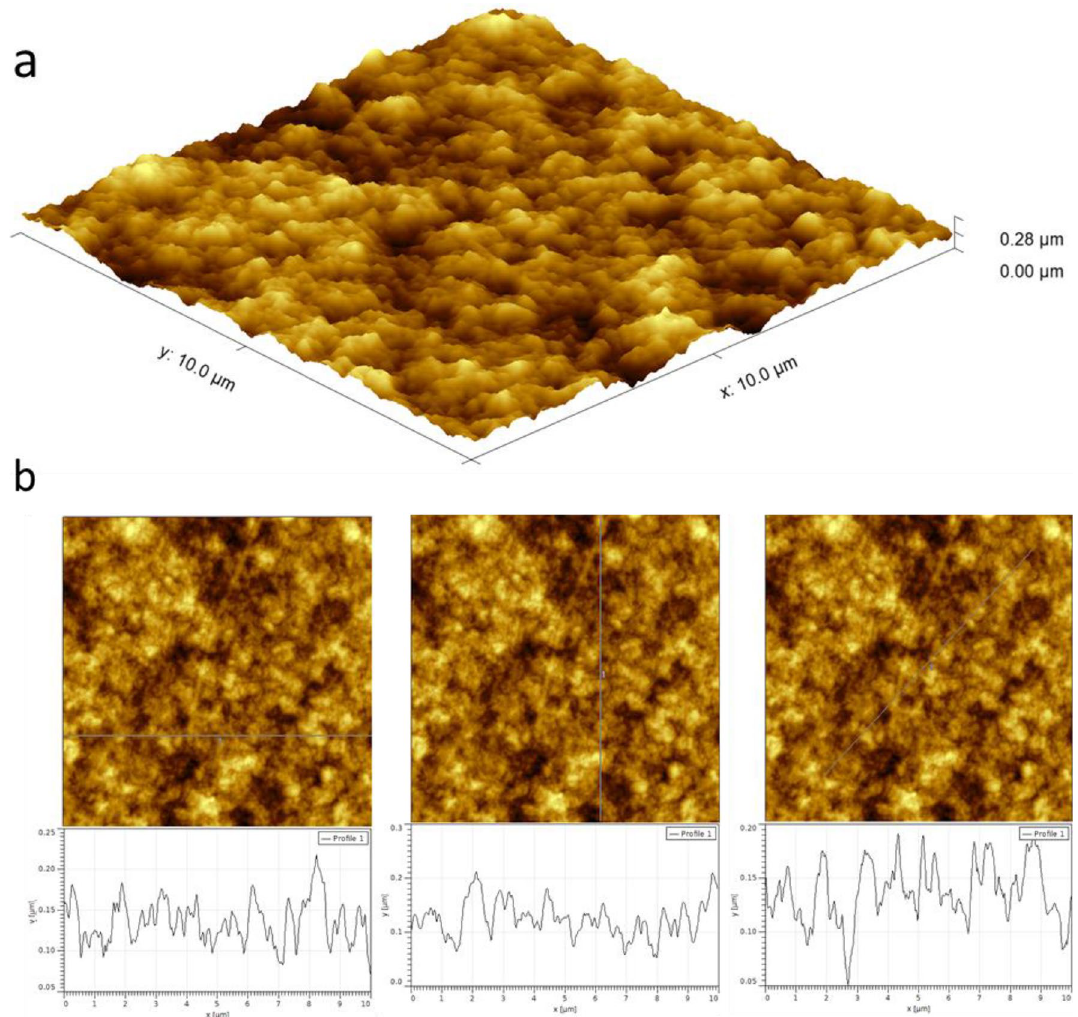
Figure 3. ( a ) AFM 3D surface topography, ( b ) AFM surface topography images with three different cross- sections measured. The size of the image is 10 × 10